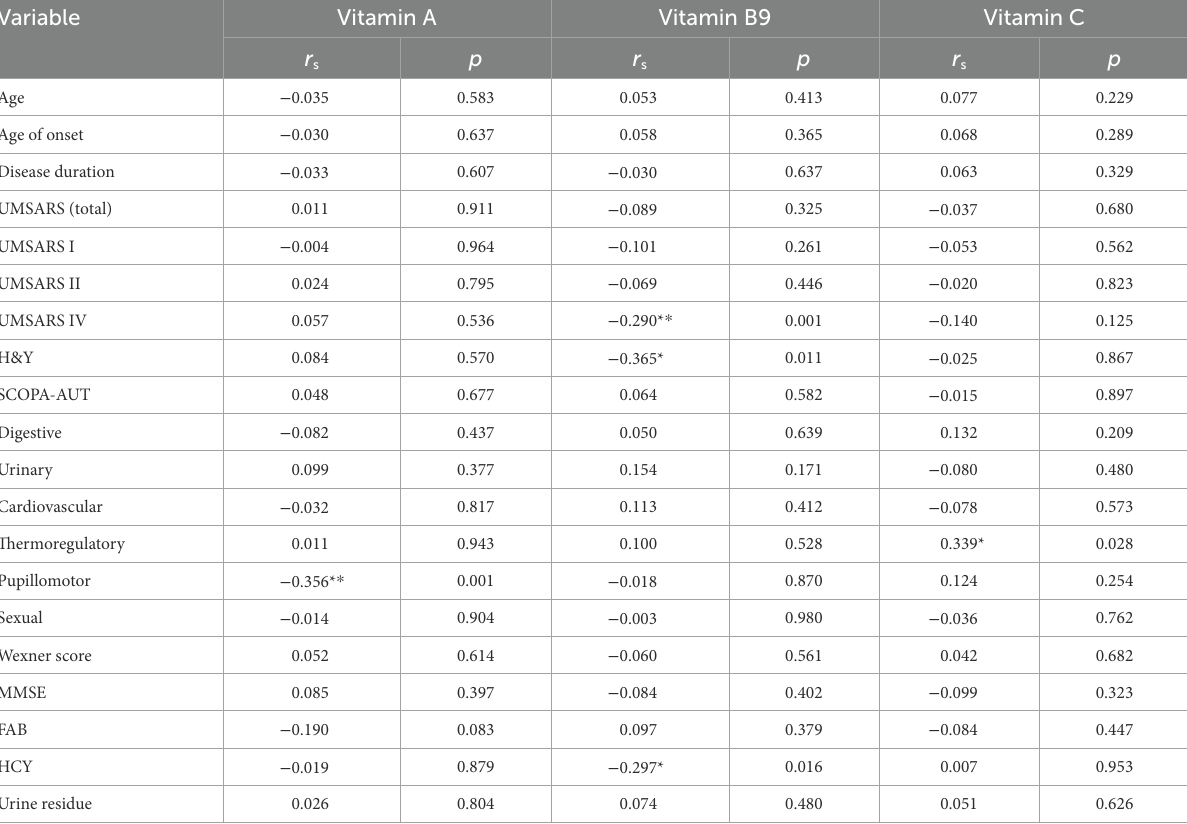
TABLE 3 Correlations between vitamin A, B9, and C with clinical characteristics of multiple system atrophy (MSA). Variable Vitamin A Vitamin B9 Vitamin